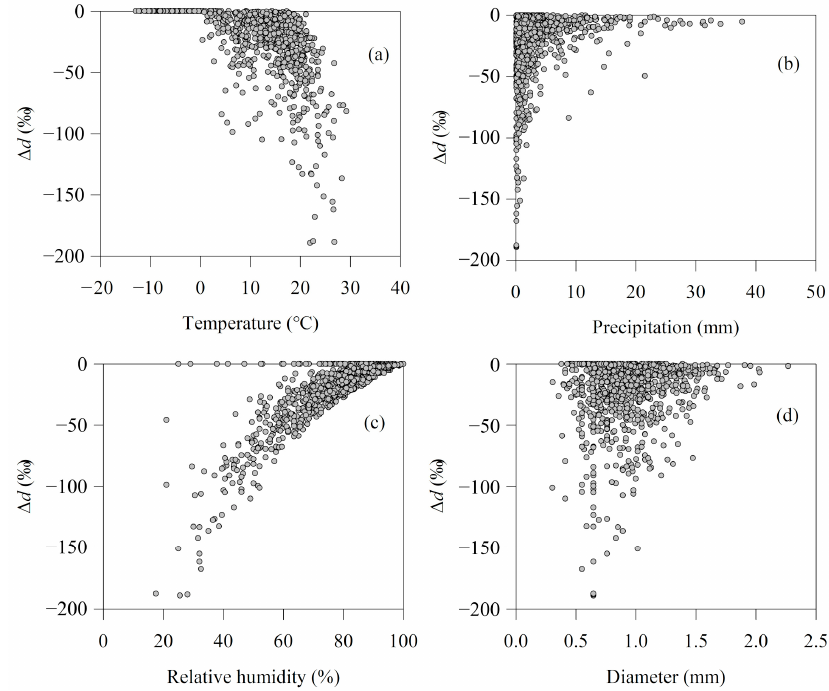
Figure 8. Relationship between meteorological parameters (( a ). air temperature, ( b ). precipitation amount, ( c ). relative humidity, ( d ). raindrop diameter) and Δ d in precipitation.